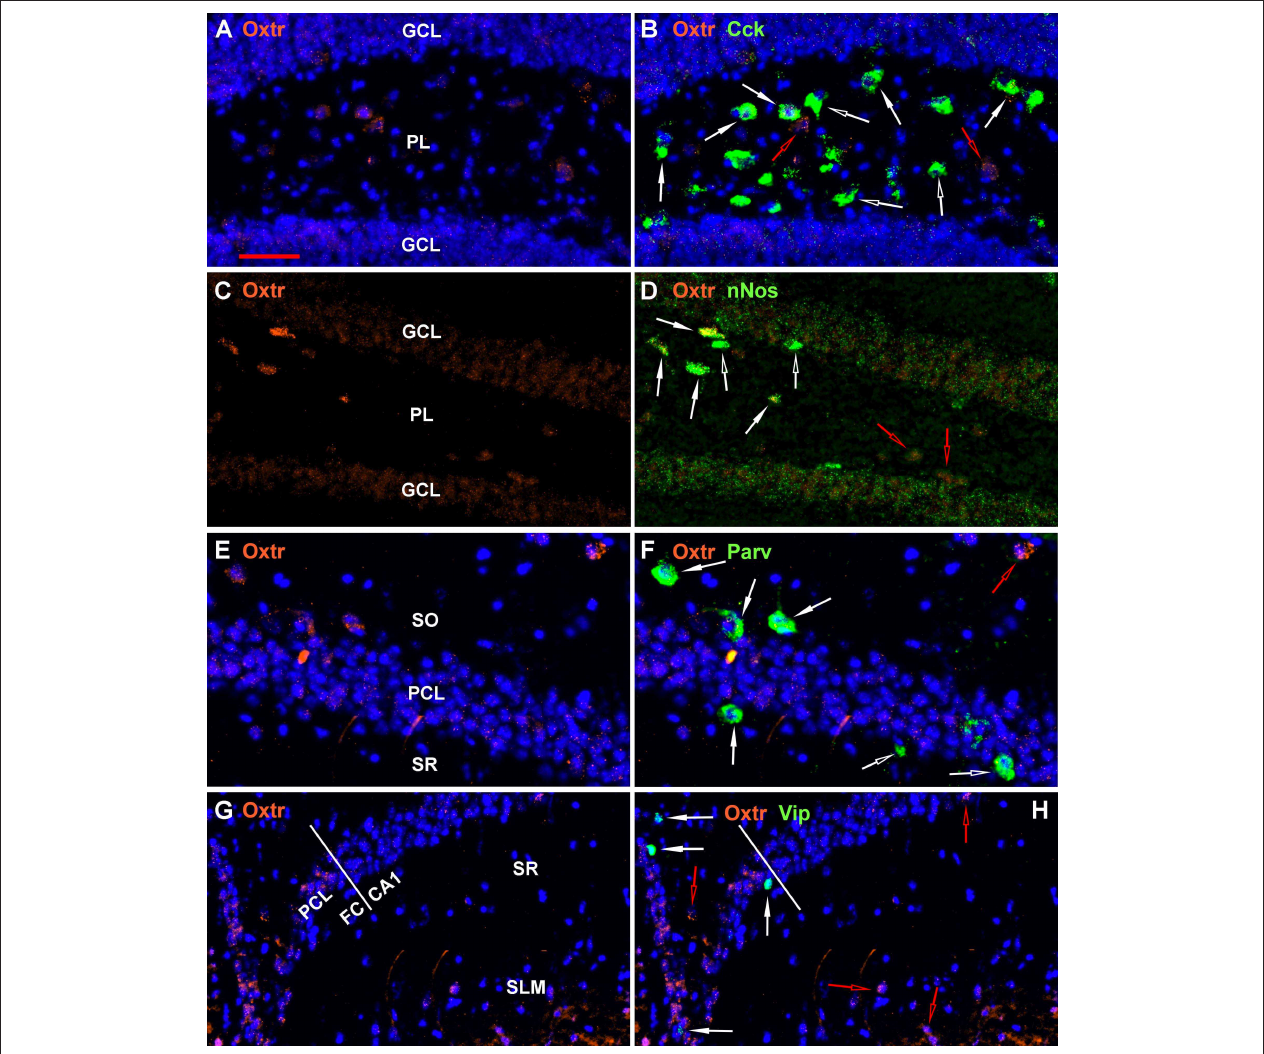
FIGURE 8 | Examples of the distribution of Oxtr within some hippocampal regions. (A) shows Oxtr expression in the DG and (B) shows its colocalization with Cck transcripts. (C) shows Oxtr expression in the DG and (D) shows its co-expression with nNos transcripts. In contrast to Cck, nNos expression is not apparent in the CA2 but is present in the CA1 pyramidal neurons. (E) shows Oxtr expression in the CA1 and (F) shows its colocalization with Parv transcripts. (G) shows Oxtr expression in the FC and CA1 regions and (H) shows its colocalization with Vip transcripts. FC pyramidal cells express Oxtr similarly to the CA2. Bar in (A) is 50 µ m and applies to all panels. Solid white arrows indicate colocalization of Oxtr transcripts with the INM transcripts. Open white arrows indicate only expression of the INM. Open red arrows indicate only expression of Oxtr.